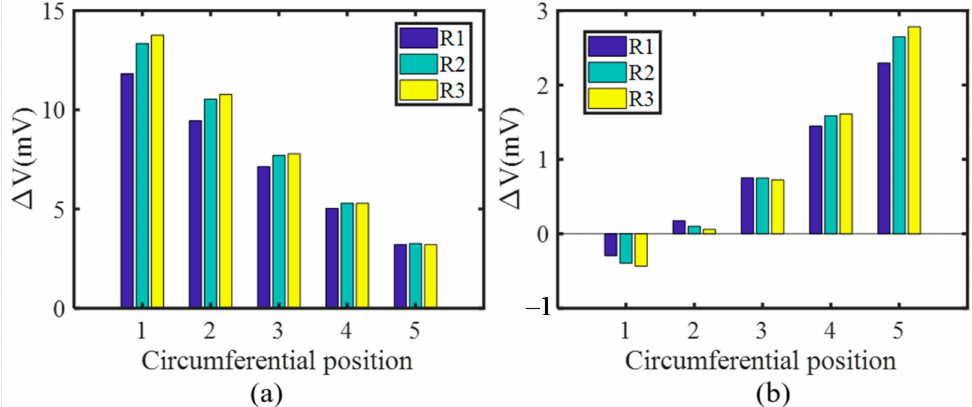
Figure 13. The induced voltage variation of S1 and S2 when the crack propagates along the radial direction at each circumferential position. ( a ) S1; ( b )